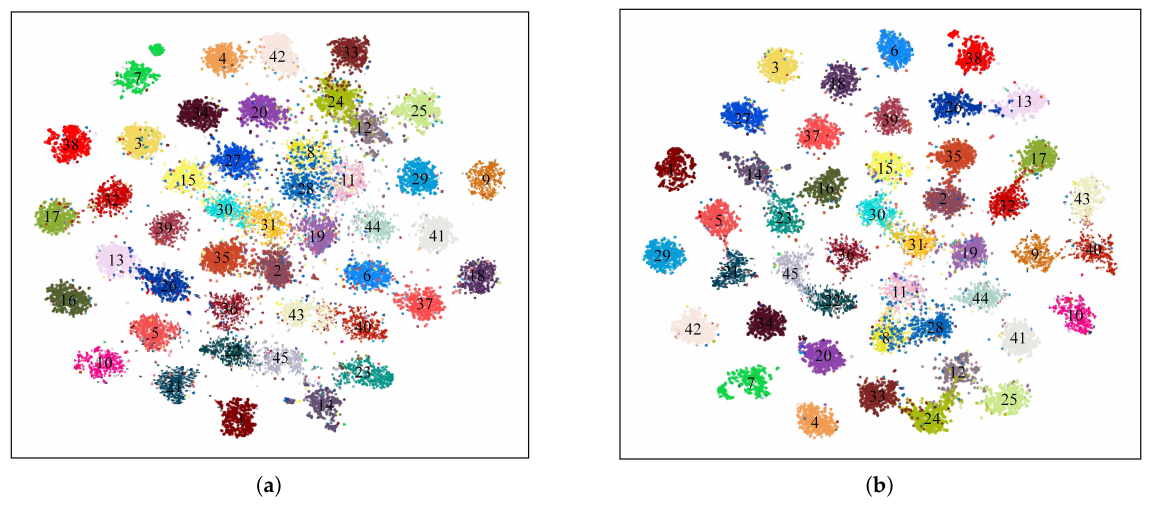
Figure 12. Two-dimensional scatterplots of high-dimensional features on the NWPU-RESISC45 dataset (training ratio = 10%). ( a ) ResNet50 backbone. ( b ) The proposed TMGAM.